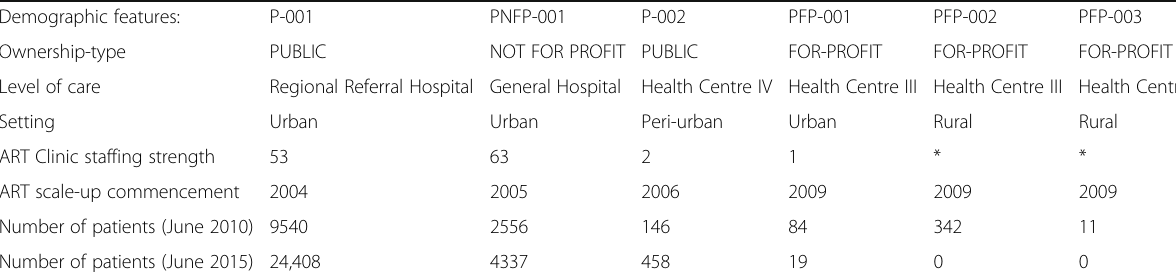
Table 2 Health facility demographic information Demographic features: